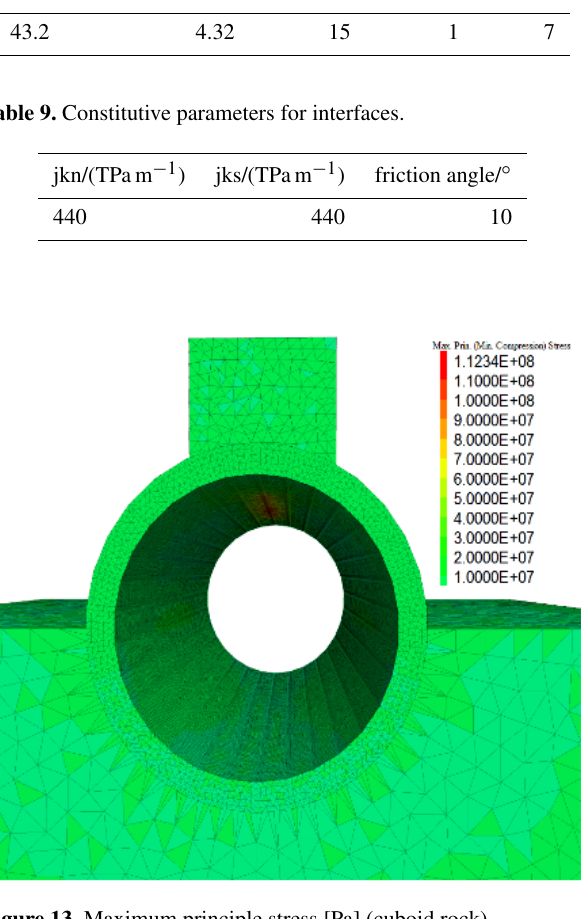
Figure 13. Maximum principle stress [Pa] (cuboid rock).